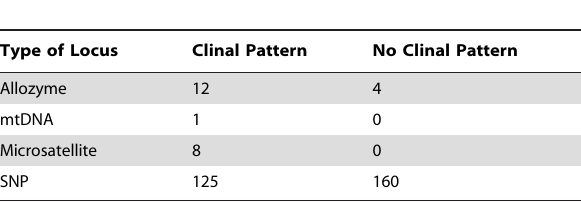
Table 2. Joint distribution of locus type and presence of clinal pattern for at least one allele based on broken-stick